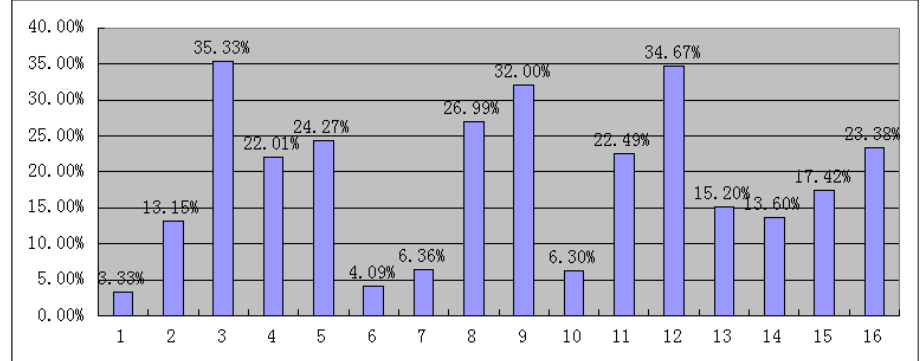
Figure 4. Rate of pedestrian violation at each studied intersection.